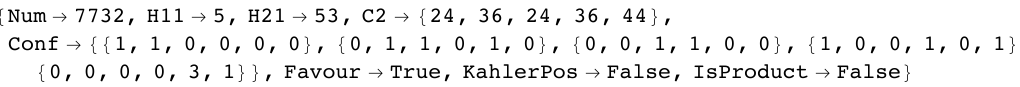
Figure 4 . An example entry in the new maximally favorable CICY